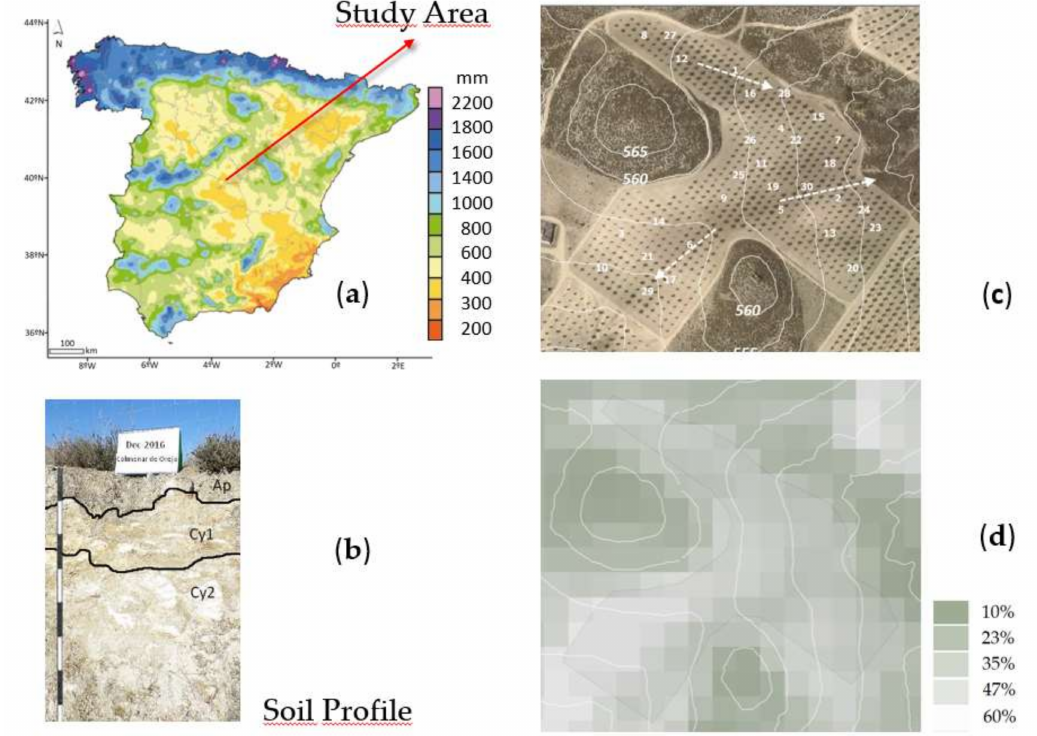
Figure 1. Location of study. ( a ) Spain Map source: National Agency Meteorology; ( b ) soil profile; ( c ) sampling sites; ( d ) Brightness Index = sqrt(B8 2 + B4 2 + B3 2 ), obtained from VIS / NIR bands of cloud-free Sentinel-2 image, acquired on 15 November 2017 and downloaded from ESA Sentinels Scientific